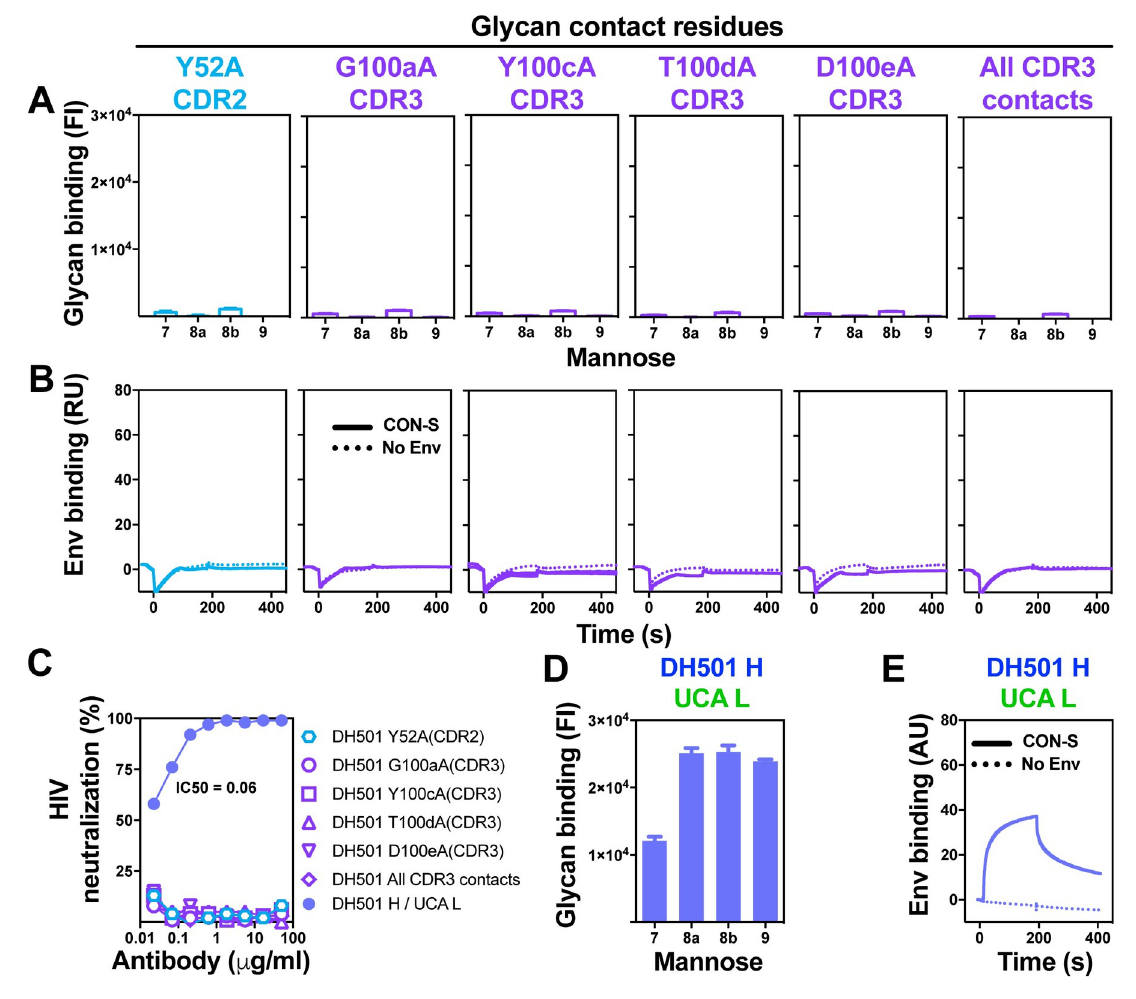
Fig 4. Germline-encoded residues in the HCDR2 and HCDR3 mediate glycan contacts and are essential for free glycan binding. Alanines were substituted for germline-encoded amino acids identified in the DH501 structure to contact glycan (circles in Fig 3A ; [37]). HCDR2 and HCDR3 substitutions are shown in cyan and purple respectively, with amino acid position indicated above each column. ( A ) Glycan binding, ( B ) HIV-1 CON-S SOSIP gp140 binding, and ( C ) Man 9 GlcNAc 2 -enriched JR-FL neutralization activity for each antibody is shown as in Fig 3A–3C . The somatically mutated antibodies are color-coded the same in A-C . (C-E) (C) Man 9 GlcNAc 2 -enriched JR-FL neutralization activity, ( D ) Glycan binding, and ( E ) HIV-1 CON-S SOSIP gp140 binding by positive control antibody DH501 H/ UCA L. Positive glycan binding based on negative control antibody binding is shown as a filled bar. Open bars indicate negative binding values. Positivity threshold for 7, 8a, 8b, and 9 was 0.18x10 4 for each glycan.